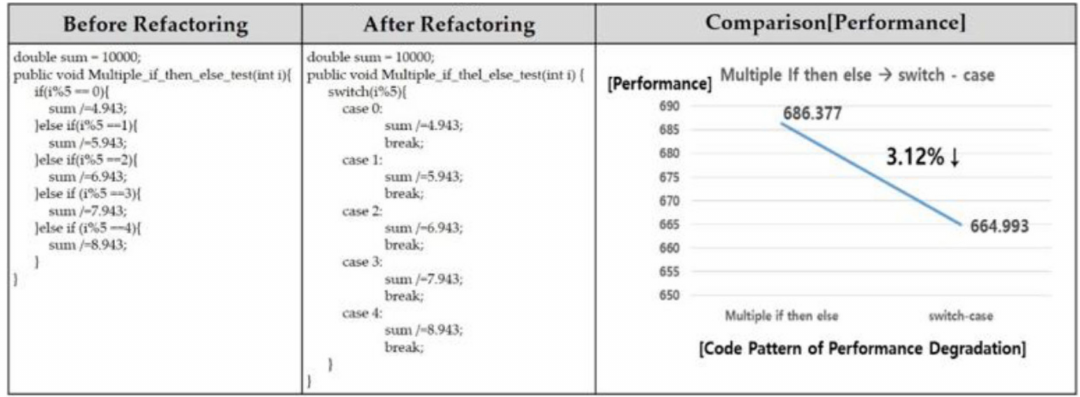
Figure 16. Before and after improving multiple if-then-else statements.